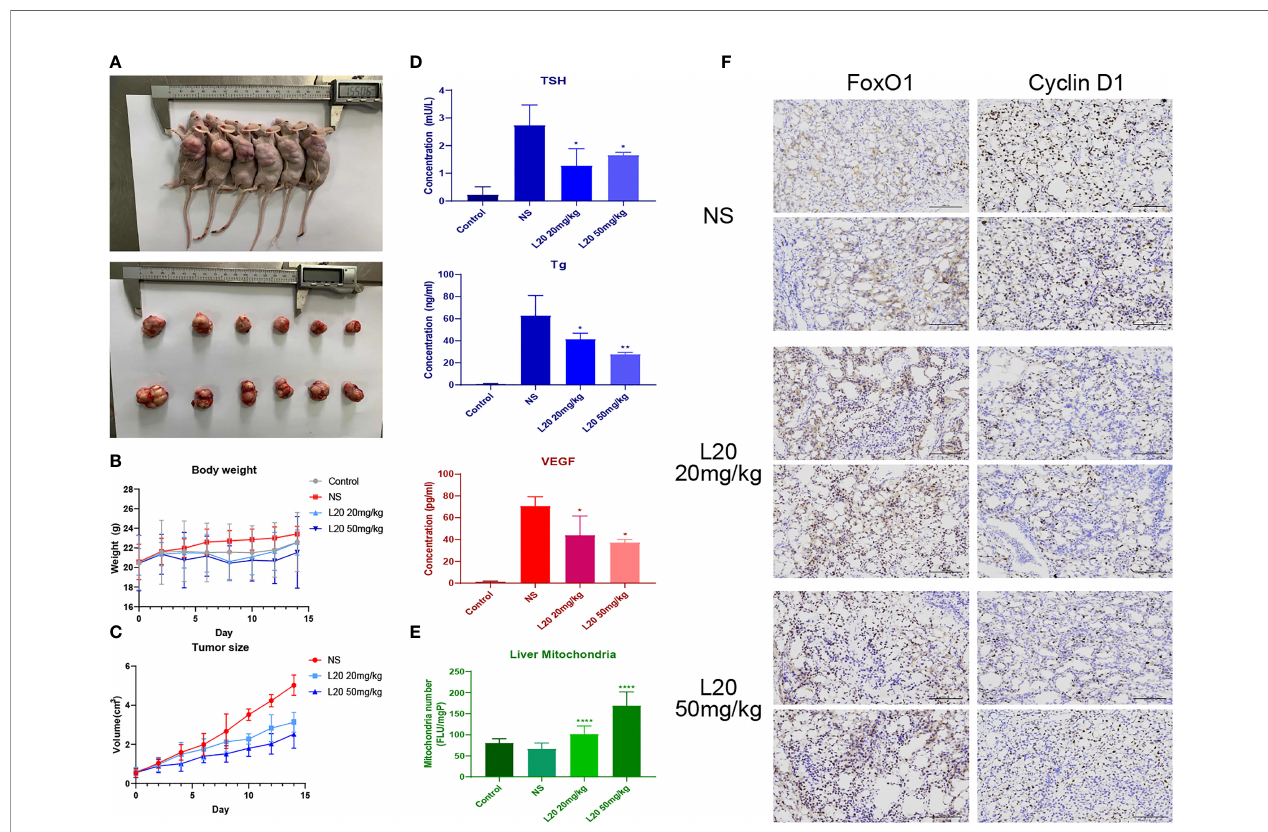
FIGURE 5 | Tumor-suppressive effects of Mito-Fu L20 and its effects on thyroid-related indicators. Treatment with Mito-Fu L20 in a subcutaneous tumor animal model. Mito-Fu L20 was injected intraperitoneally, followed by measurements of body weight and tumor volume every other day (A) . Tumors removed from nude mice on day 14. (B) Body weight and (C) tumor size were measured every other day; tumor volumes were calculated using the ellipsoid formula: V = (length × width 2 ) × p /6. (D) Levels of TSH, Tg, and VEGF were measured in peripheral blood samples. (E) Quanti fi cation of the number of mitochondria in liver tissue and comparison between the NS and drug treatment groups. (F) Tumor specimens were subjected to IHC staining (scale bar: 100 m m). Data are shown as means ± SDs (n = 6 for each group). *P < 0.05, **P < 0.01, ***P < 0.005, ****P < 0.001. NS, Normal